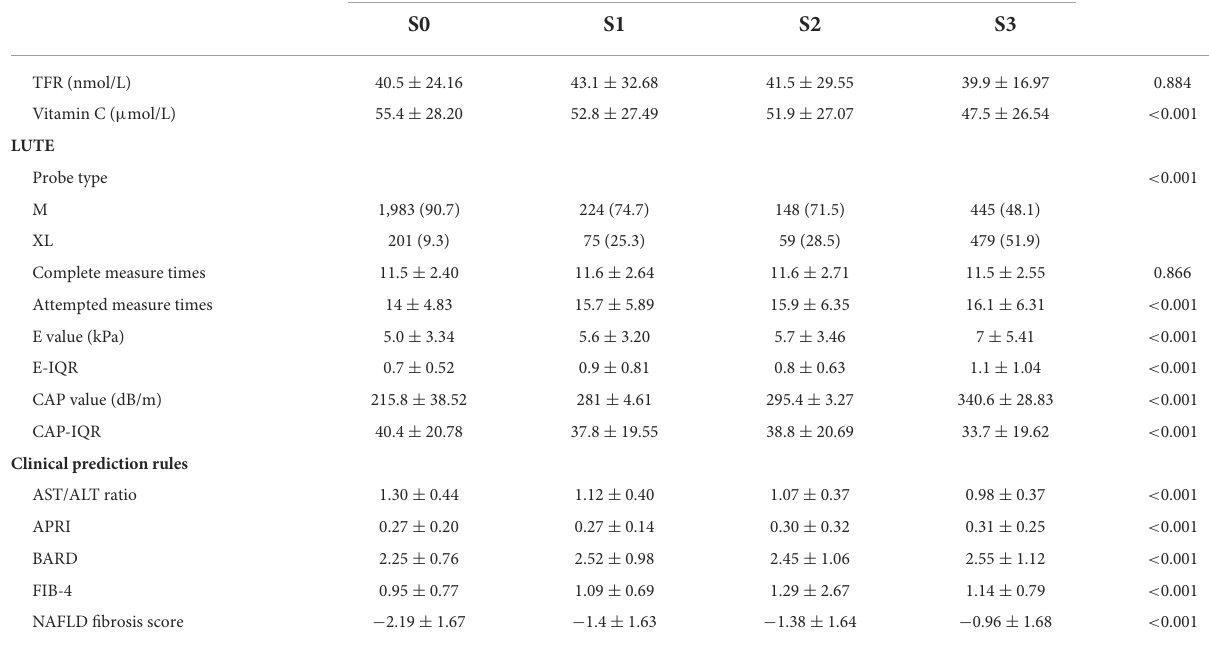
presented in Table 3. To avoid the bias caused by any possible leverage values, we have also used the RCS model to fit the non-linear relationship between Vit C, ferritin, and NAFLD, we found that the odds ratio of NAFLD increased significantly with increasing serum ferritin after adjusting for covariates ( P < 0.001, Figure 2A), while serum Vit C showed the opposite trend ( P < 0.001, Figure